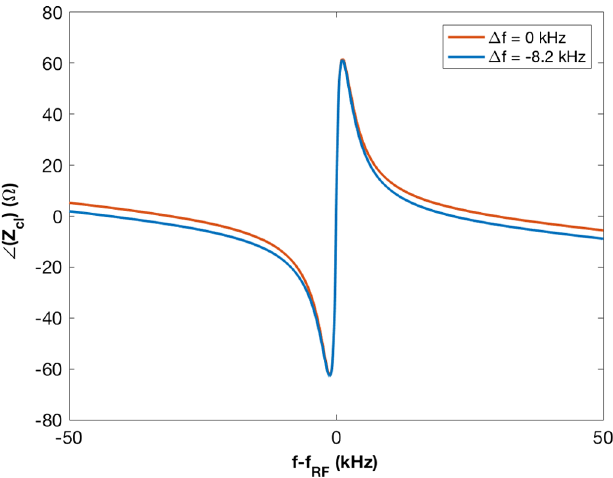
FIG. 10. Modulus of Z cl . Physics settings: Q L ¼ 60000 , V ¼ 2 MV, detuning of − 8 . 2 kHz. Rf station optimized with c zero detuning.